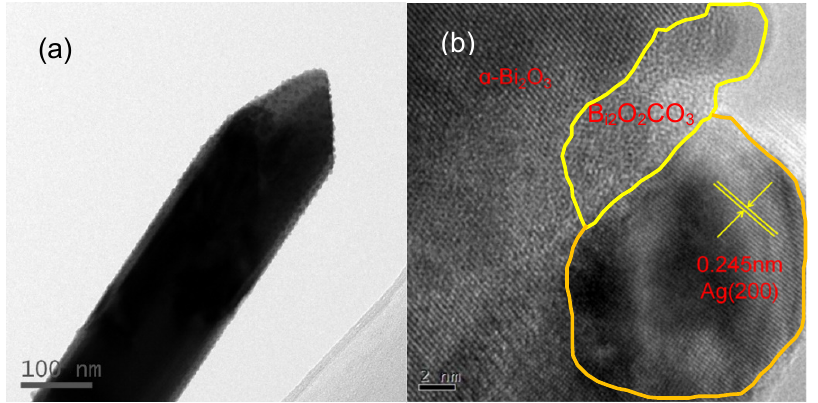
α -Bi 2 O 3 heterojunction